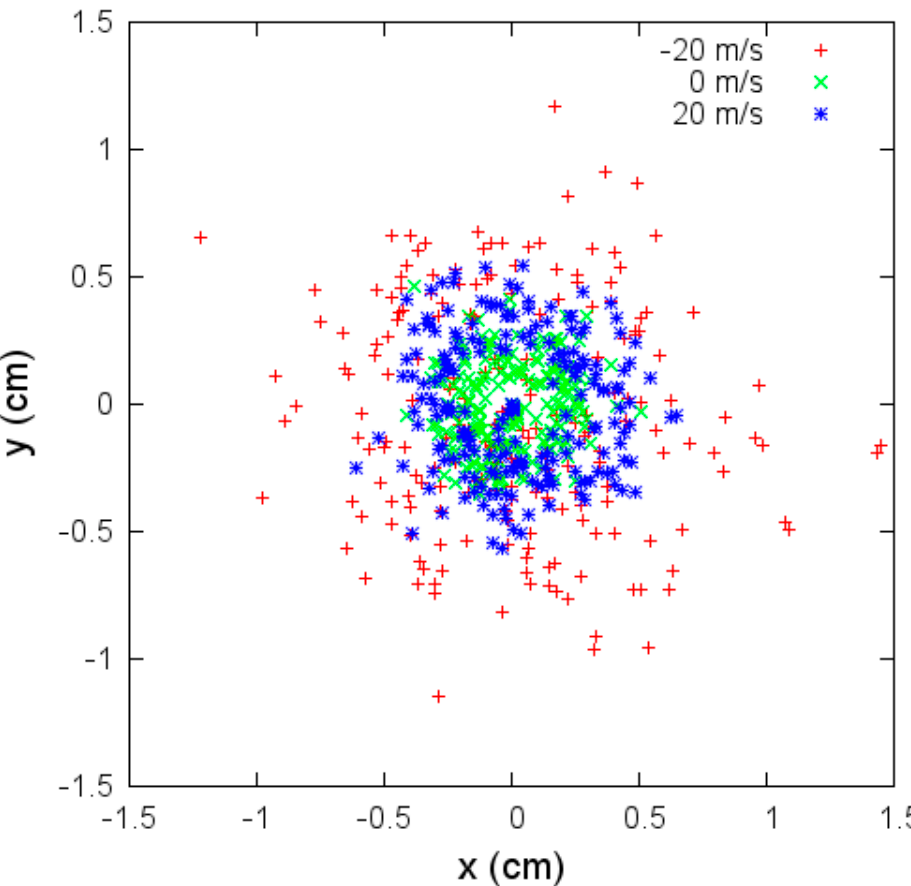
Figure 8. Coordinates x and y where the jet bead hits the collector for different flow velocities, v f under parameters given in Table 3.